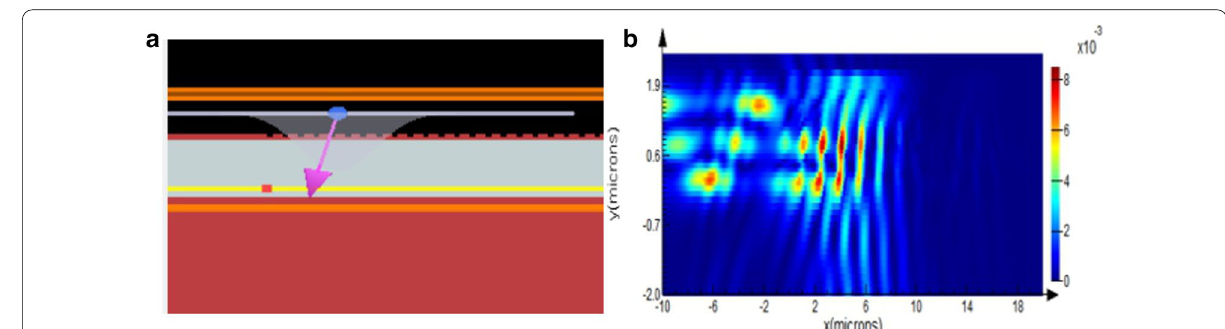
Fig. 3 a Simulation structure of the light coupling process, b electromagnetic distribution of the in coupling